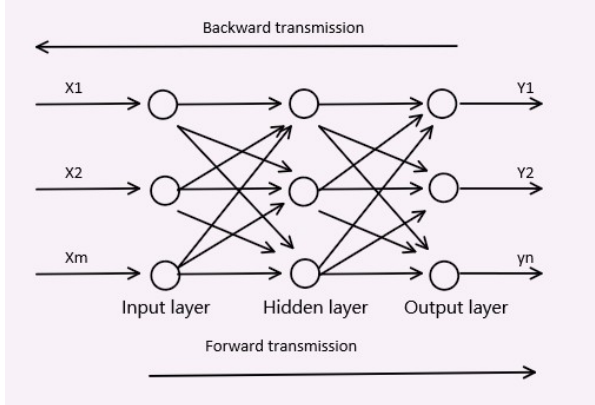
Figure 3. A simple BP neural